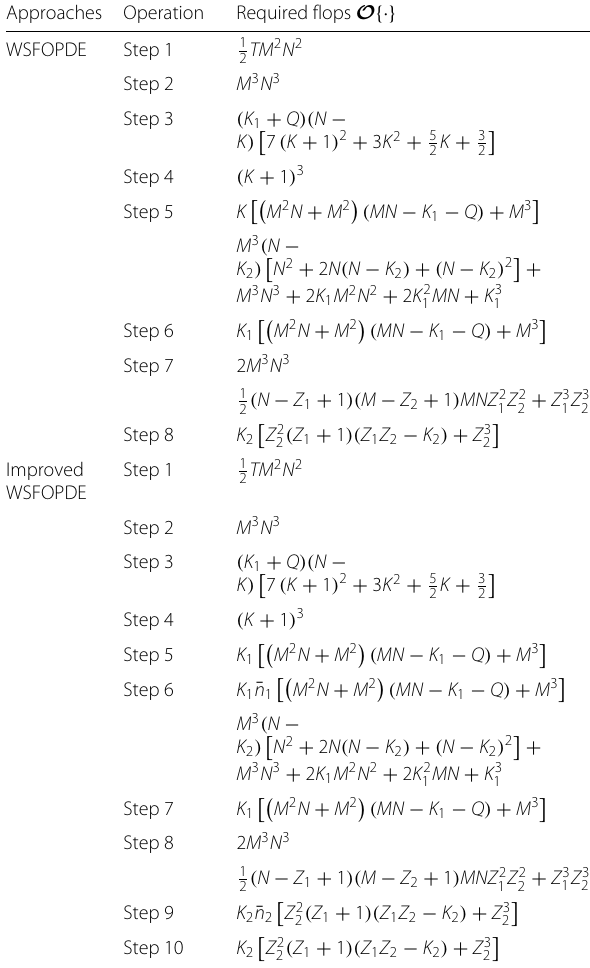
Table 3 Analysis of the computational complexity Approaches